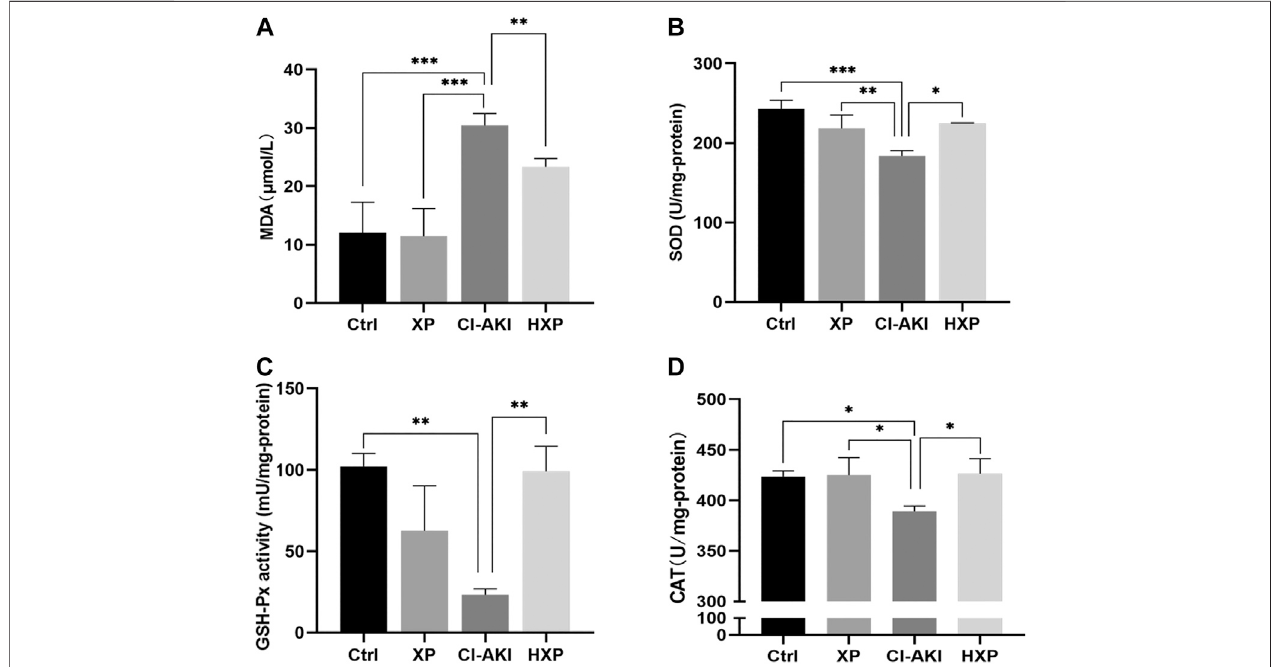
FIGURE 7 | Inhibition of iohexol-induced oxidative stress by XP pretreatment. (A) The amount of malondialdehyde (MDA) was measured in the four groups. (B) SOD levels were measured in the four groups. (C) GSH-Px levels were measured in the four groups. (D) CAT levels were measured in the four groups. An increase of MDA and a reduction of SOD, GSH-Px and CAT were detected in iohexol-injured kidneys, which were remarkably restored in the HXP group. Data are presented as mean ± SEM( n (cid:1) 6ineachgroup).* p < 0.05;** p < 0.01;*** p < 0.001basedonone-wayanalysisofvariance.MDA,malondialdehyde;SOD,superoxidedismutase; GSH-Px, Glutathione peroxidase;CAT, catalase; Ctrl, control; CI-AKI, contrast induced-acute kidney injury; LXP, low dose XP combined with iohexol; MXP, medium dose XP combined with iohexol; HXP, high dose XP combined with